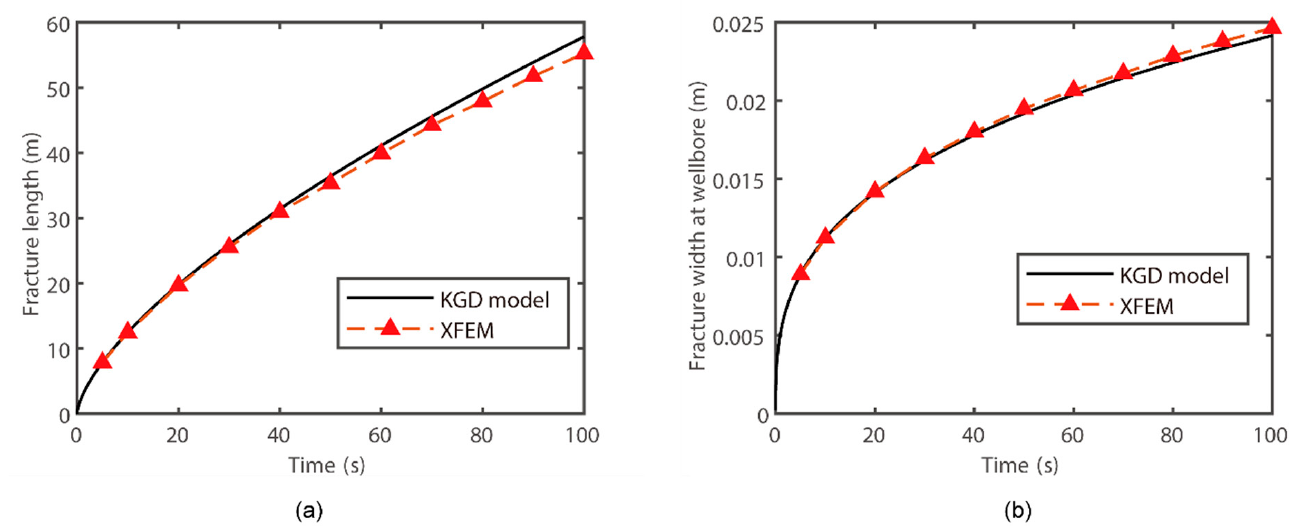
Figure 5. Comparison of KGD and UXFEM, ( a ) Comparison of fracture length, and ( b ) Comparison of fracture width at the wellbore.